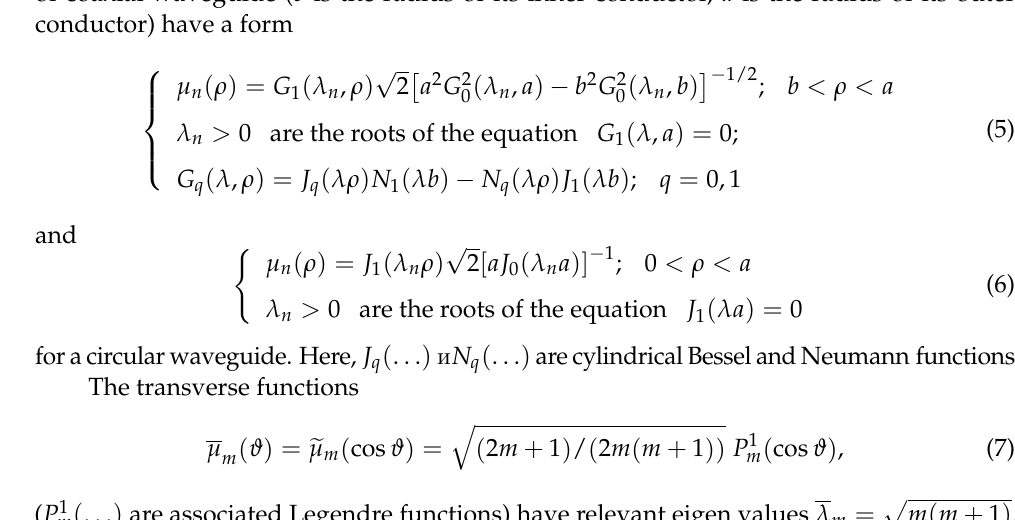
E H φ φ - or - field component of the exciting 0 p